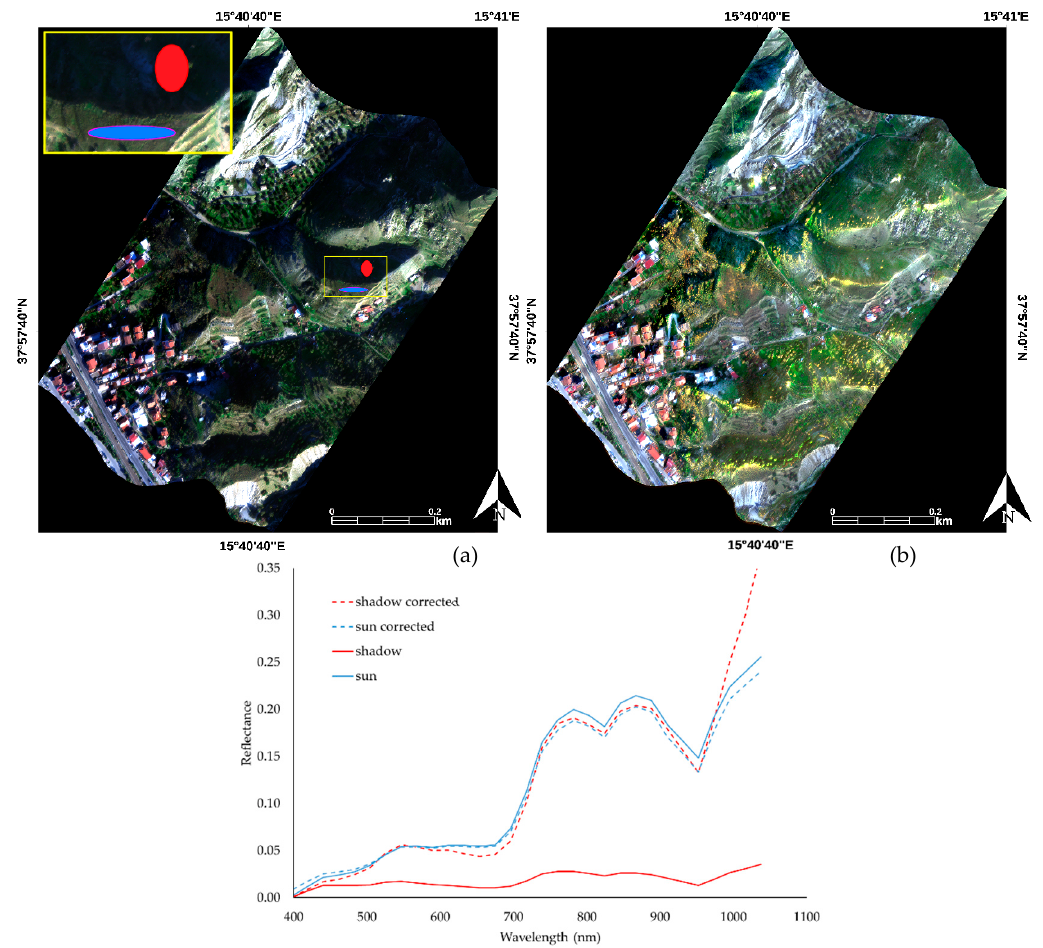
Figure 15. RGB (R: 653 nm, G: 546 nm, B: 439 nm) images before ( a ) and after ( b ) the application of topographic correction related to a subsets of the Reggio Calabria CASI image, corresponding to a mountain context. The zoomed area in (a) highlights the ROIs relates to shadow (red) and exposed (blue) areas. On the graph the mean spectra of the two ROIs, before (solid lines) and after (dashed lines) the application of topographic corrections are shown.